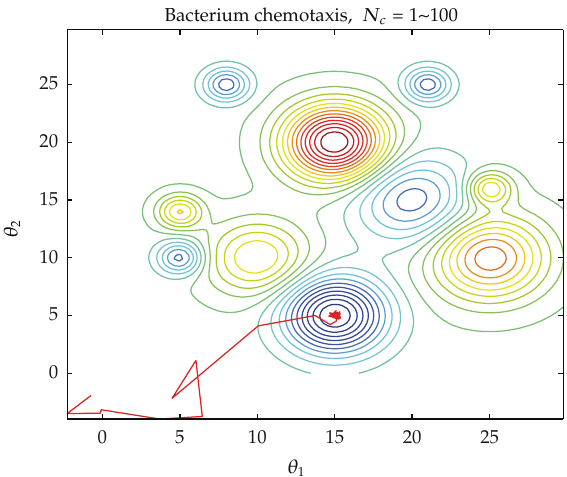
Figure 16: Optimal process of one bacterium when chemotaxis ranges between 1 ∼